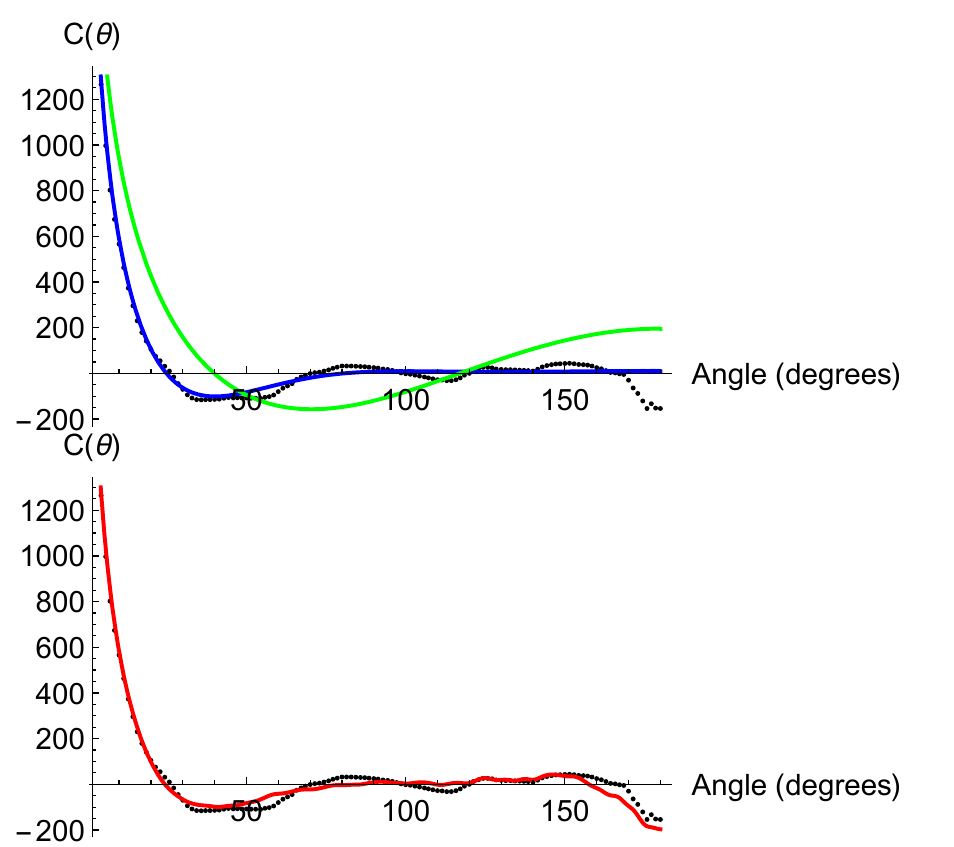
Figure 1. Two-point correlation function C ( θ ) ) (solid curves) obtained from the fit to Planck 2018 data. Upper panel : Λ CDM prediction (in green) clearly deviating from data in almost the whole angular range; blue curve: u min = 4.5 without imposing a odd-parity dominance requirement. Lower panel : = 4.5 with odd-parity dominance from Red curve for u even min